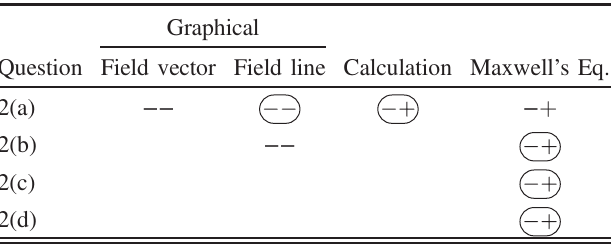
TABLE III. Analysis of answers given by student B regarding the divergence of electric fields [questions 2(a) –